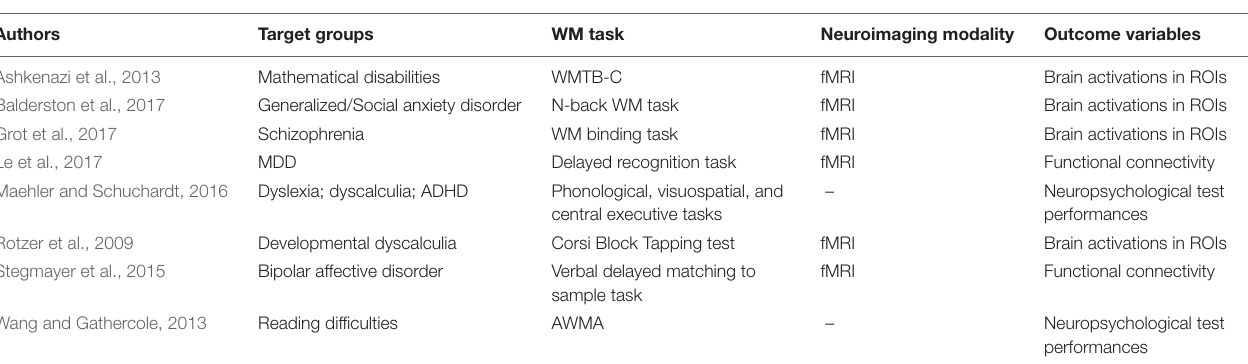
TABLE 3 | Working memory (WM) studies in the diseased